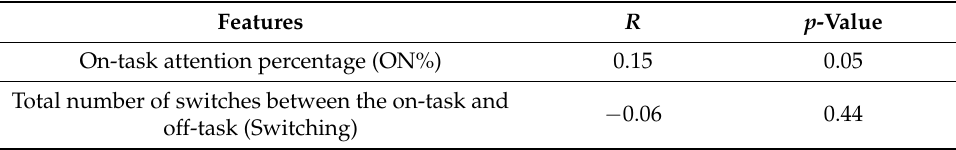
Table 7. Pearson’s Correlation Coefficient ( r ) and p -value between Final Grade and the Attention